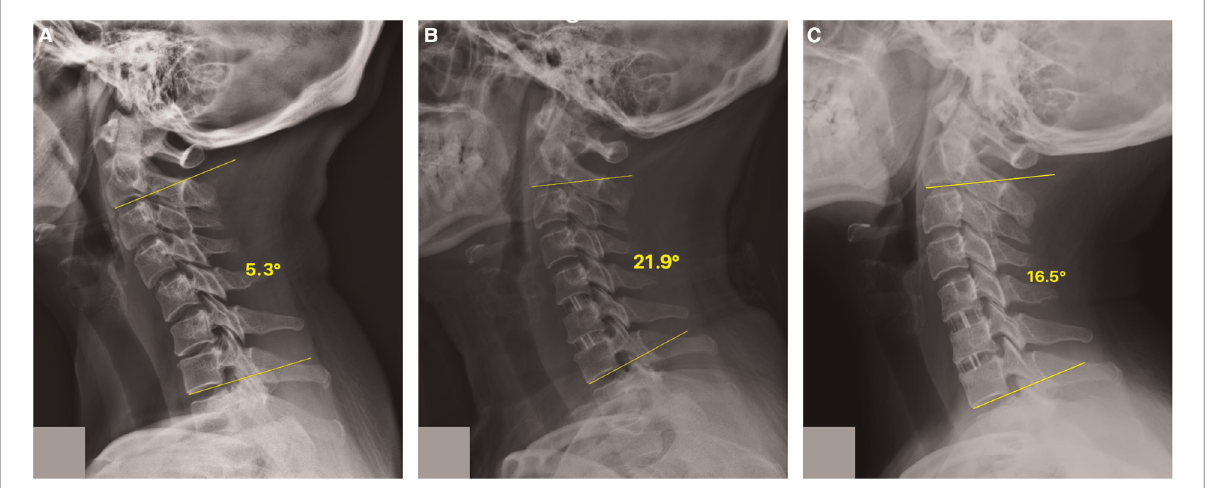
FIGURE 2 A case of the ST group. Cervical lateral radiographs of a 56-year-old woman from the ST group showing the C2 – C7 Cobb angle at different time points. ( A ) 5.3° preoperatively; ( B ) 21.9° postoperatively; ( C ) 16.5° at the fi nal follow-up. ST, stand-alone cage.